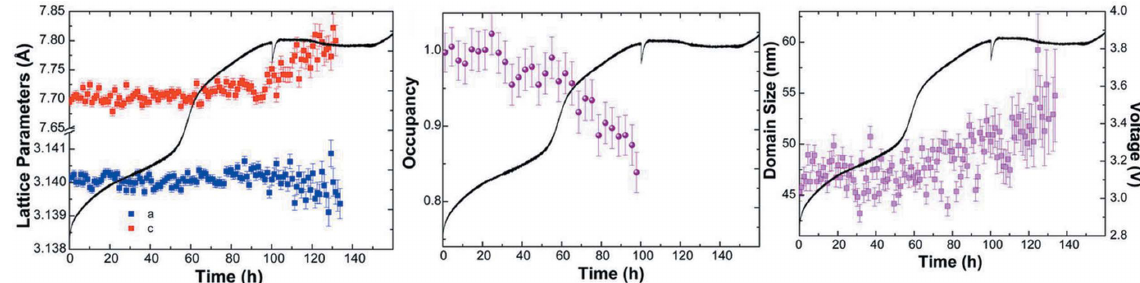
Figure 6 Charging of electrochemically formed Li 2 O 2 , showing the time evolution of lattice parameters, lithium occupancy and average domain size, with the corresponding voltage profile also shown. Reprinted and adapted with permission from Ganapathy et al. (2014). Copyright (2014) American Chemical